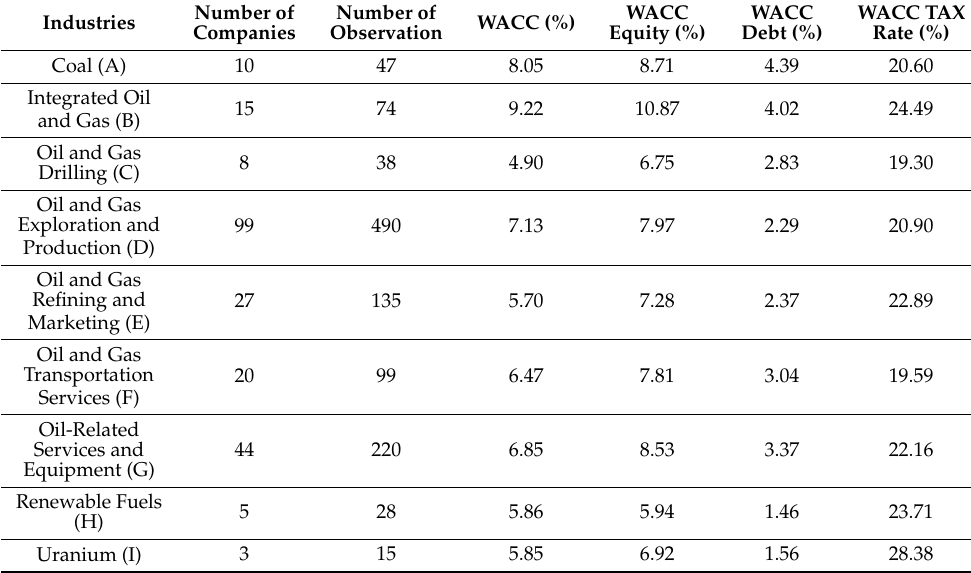
Table 5. WACC, WACC equity, and WACC debt in the industry overview